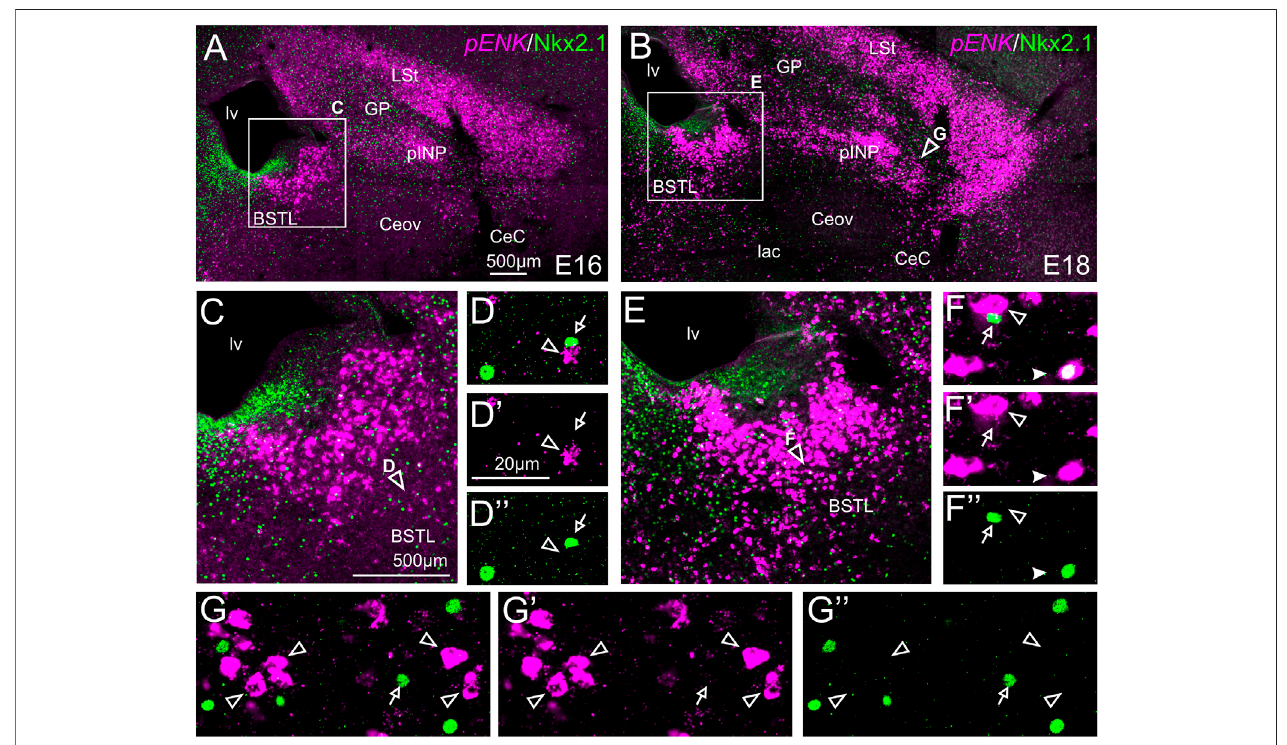
FIGURE 4 | Double fl uorescence labeling of pro-ENK ( pENK ) and Nkx2.1 in the chicken central extended amygdala at E16 and E18. (A,B) General views (×10 objective) of the subpallium in frontal sections at the level of the anterior commissure, from E16 (A) or E18 (B) chicken brain, processed for indirect fl uorescent in situ hybridizationfor pENK (magenta)andimmuno fl uorescenceforNkx2.1(green). (C,E) showampli fi cationsofthesquaredareasin (A) or (B) ,respectively,atthelevelofthe BSTL. Details (×40 objective, only one single z level of the confocal stack) of the areas pointed with arrowheads in (C,E) are shown in (D – D 99 ,E – E 99 ) (merged plus separate magenta and green channels are shown). Additional details of the areas pointed with arrowheads in (B) are shown in (G – G 99 ) (for pINP). In these details, cells coexpressing pENK and Nkx2.1 are pointed with a fi lled arrowhead, cells single labeled for pENK are pointed with an empty arrowhead, while cells single labeled for Nkx2.1 are pointed with an empty arrow (only a few examples are pointed). See text for more details. For abbreviations see list. Scale bars: (A) = 500 μ m [applies to (A,B) ]; (C) = 500 μ m [applies to (C,E) ]; (D 9 ) = 20 μ m [applies to (D – D 99 , F – F 99 ,G – G 99 )